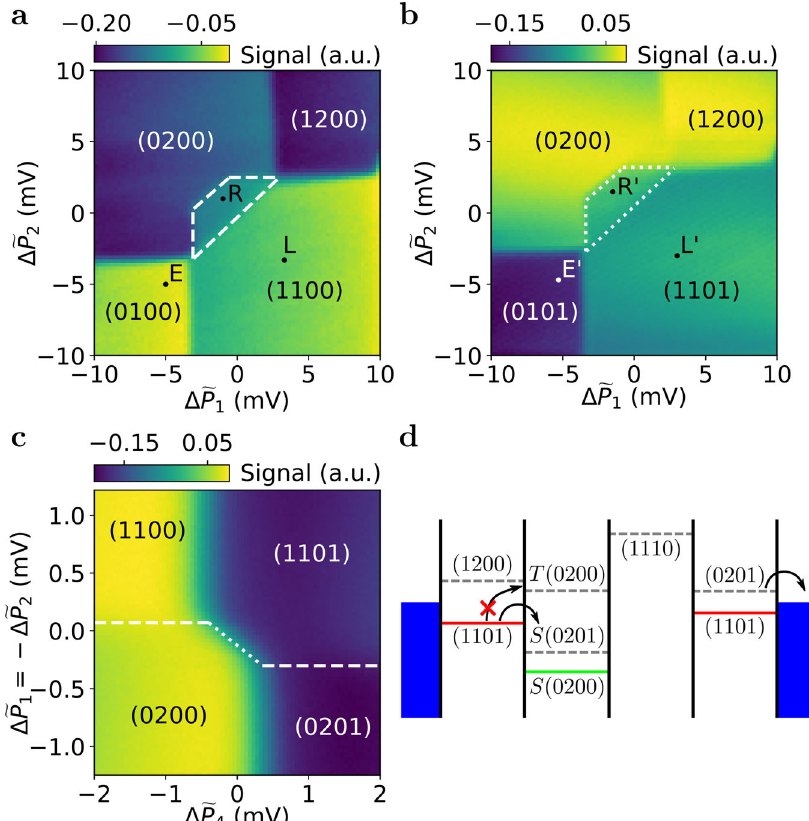
Fig. 2 Quantum dot tuning for cascade-based readout. Numbers in round brackets indicate charge occupations of the dots. a Charge-stability diagram with transitions for dots 1 and 2. The white, dashed trapezoid on the top-left side of the inter-dot is the Pauli spin blockade (PSB) readout region. The black dots indicate the voltages for the PSB readout cycle: E(mpty), L(oad) and R(ead). b Charge-stability diagram similar to a , but with different occupations of the rightmost dot. The white, dotted trapezoid is the cascade Pauli spin blockade (CPSB) readout region. White and black dots labelled with E 0 , L 0 and R 0 indicate the pulse positions for the CPSB readout cycle. Note that the voltages at the origin are different from those in a . c Charge-stability diagram showing both the charge states for PSB and CPSB readout. Dashed (dotted) lines correspond to the charge transitions for the PSB (CPSB) readout regions. d Ladder diagram illustrating the alignment of the dot electrochemical potentials for the CPSB at the readout point. For a triplet state, the system remains in (1101) (red), whereas for a singlet state it transitions to (0201) and then (0200)